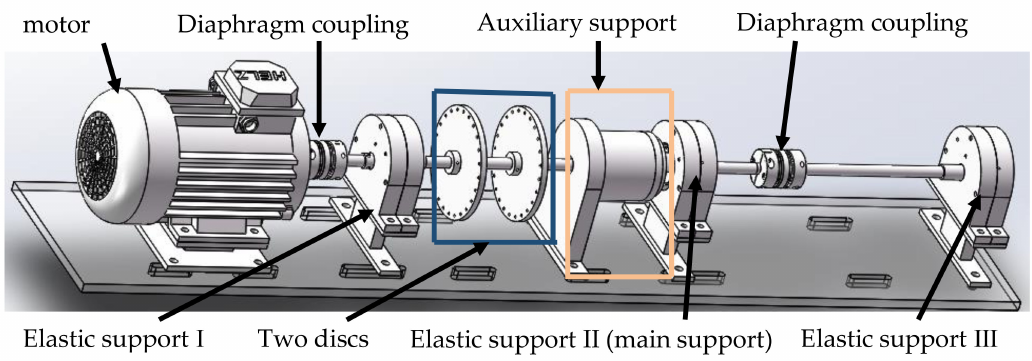
Figure 1. Three-dimensional model of three-support shafting.